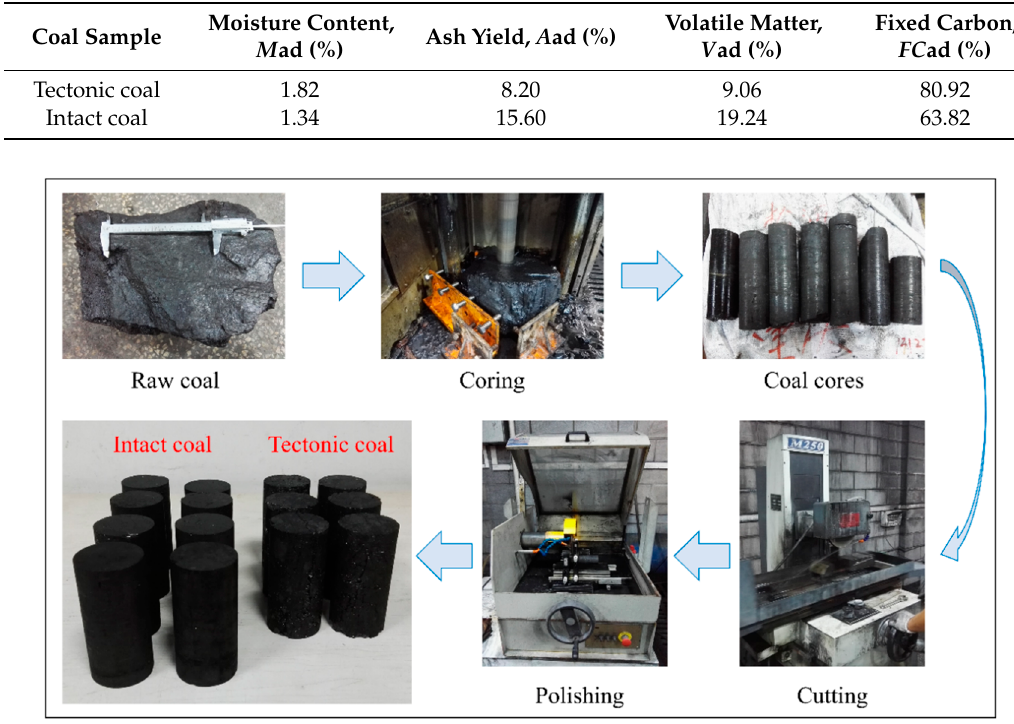
Figure 2. Manufacturing processes of coal samples.